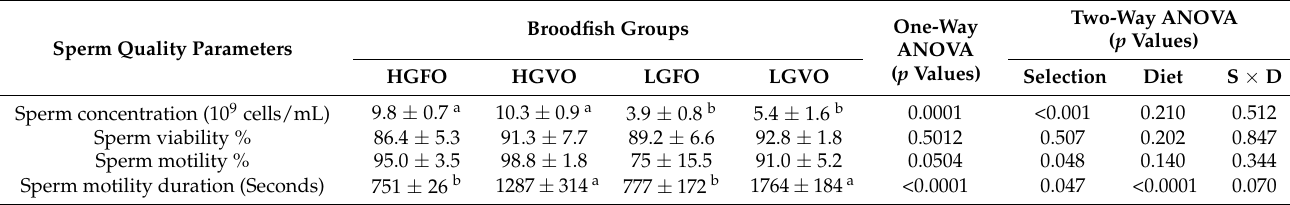
Table 10. Sperm quality of gilthead seabream broodstock selected for high (HG) or low (LG) growth fed with either FO or VO diet over three months of reproductive season (HGFO, n = 4; HGVO, n = 4; LGFO, n = 5; LGVO, n = 5).